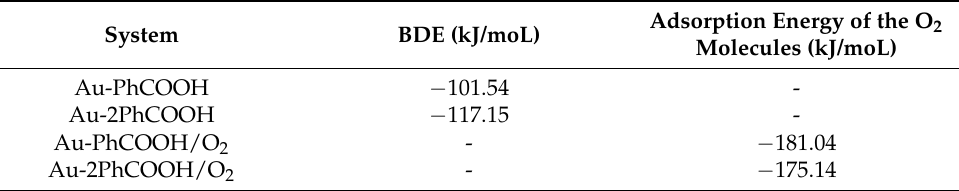
Table 3. BDE and adsorption energy of oxygen molecule on Au after grafting with two CP groups (level of theory: GGA/DND/TS).